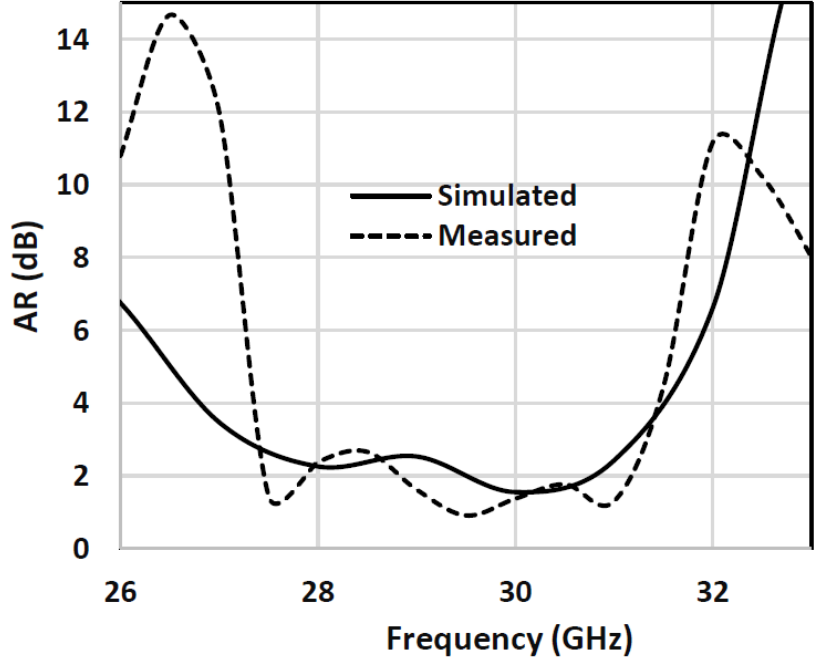
Figure 19. The simulated and measured axial ratio of the DRA array. Figure 19 . The simulated and measured axial ratio of the DRA array. Figure 19 . The simulated and measured axial ratio of the DRA array.